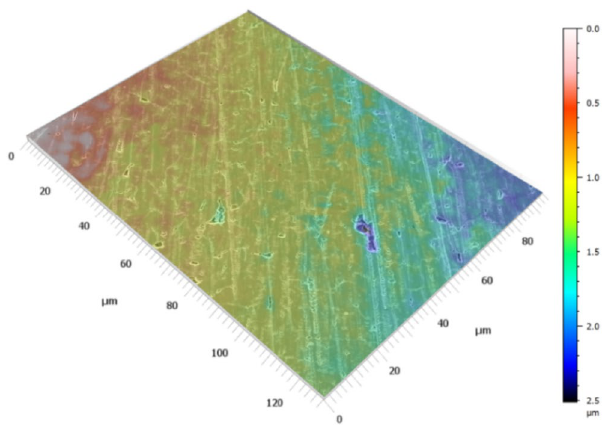
Figure 4. 3D reconstruction of a Type 1/Normal leaching Surface from a 10 W cm −2 , 7.5 h experiment created using MountainsSEM. Minimal to no erosion has occurred. Changes in surface area are caused by preferential leaching of scratch marks and microcracks. The leveling function of MountainsSEM has trouble working on relatively flat surfaces so the slight downward slope of the reconstructed surface has not been